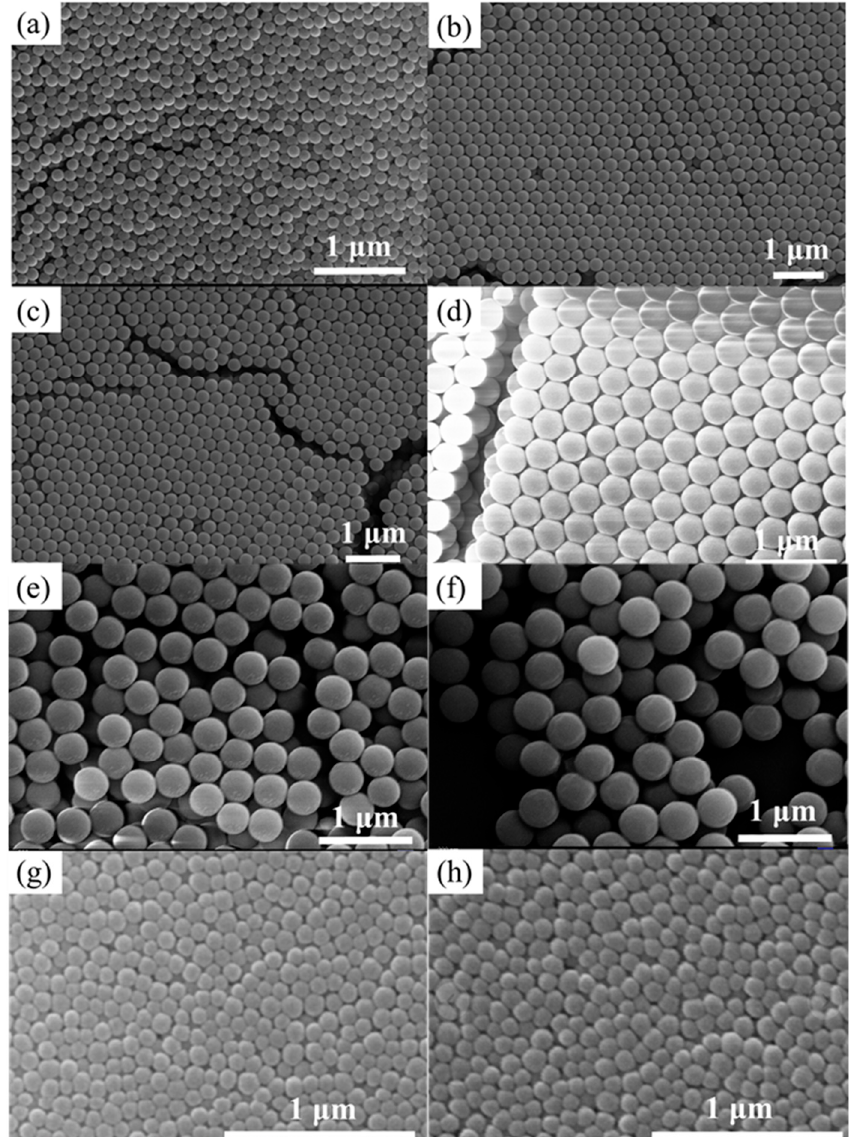
Figure 1. SEM images of ( a ) 186 nm silica microspheres (SMs); ( b ) 243 nm SMs; ( c ) 256 nm SMs; ( d ) 343 nm SMs; ( e ) 564 nm SMs; ( f ) 763 nm SMs; ( g ) 94 nm SMs; and ( h ) 86 nm SMs.